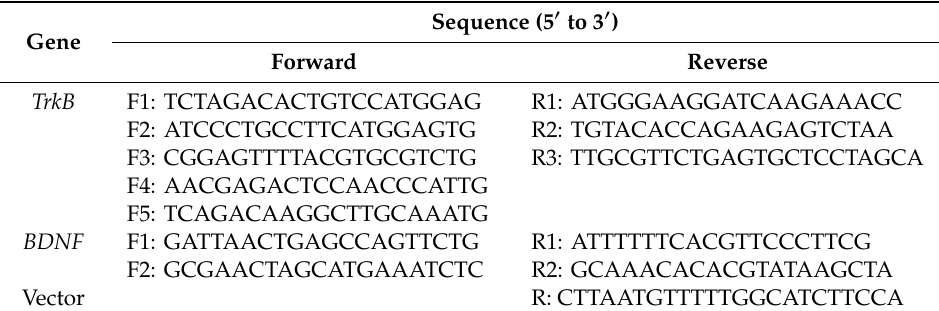
Table 4. Sequencing primers for reporter